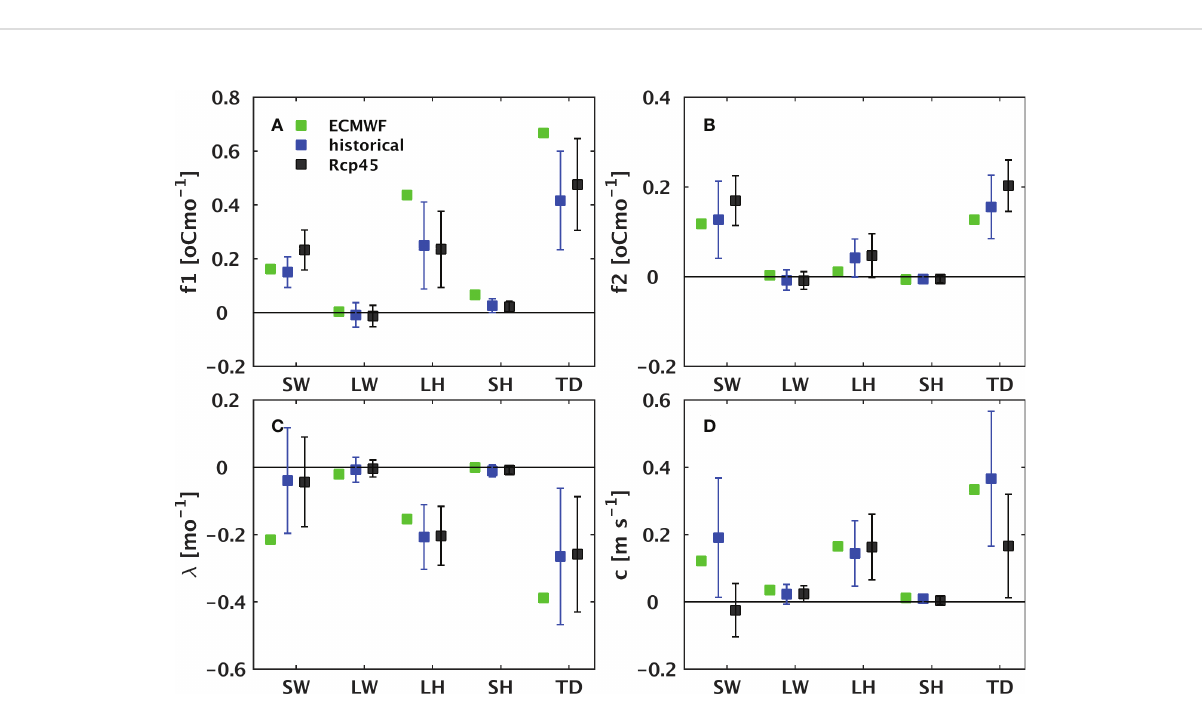
FIGURE 7 Same as Figure 6, but for contributions from the thermodynamic (TD) process and its components, the SW, LW, LH and SH. Whiskers represent the inter-model standard